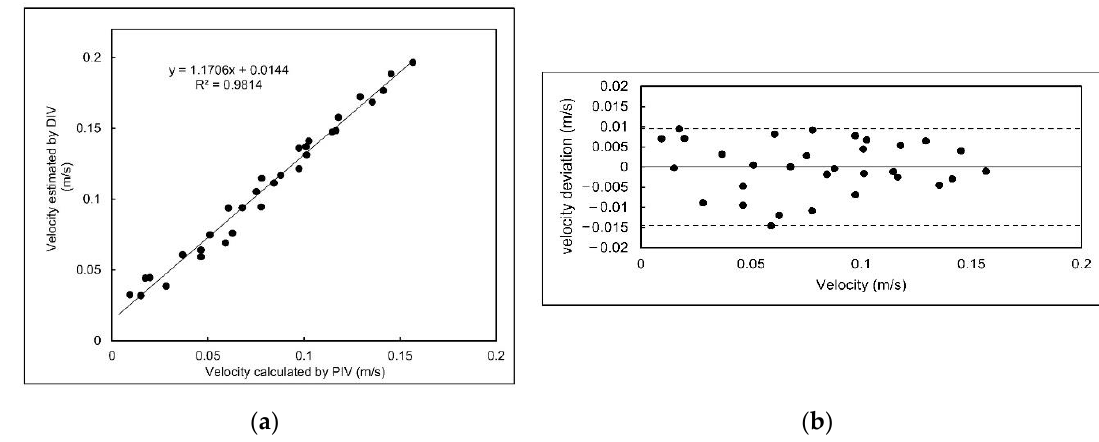
Figure 5. ( a ) Calibration curve; ( b ) plot of deviation data for Dye Injection Velocity (DIV) calibration.